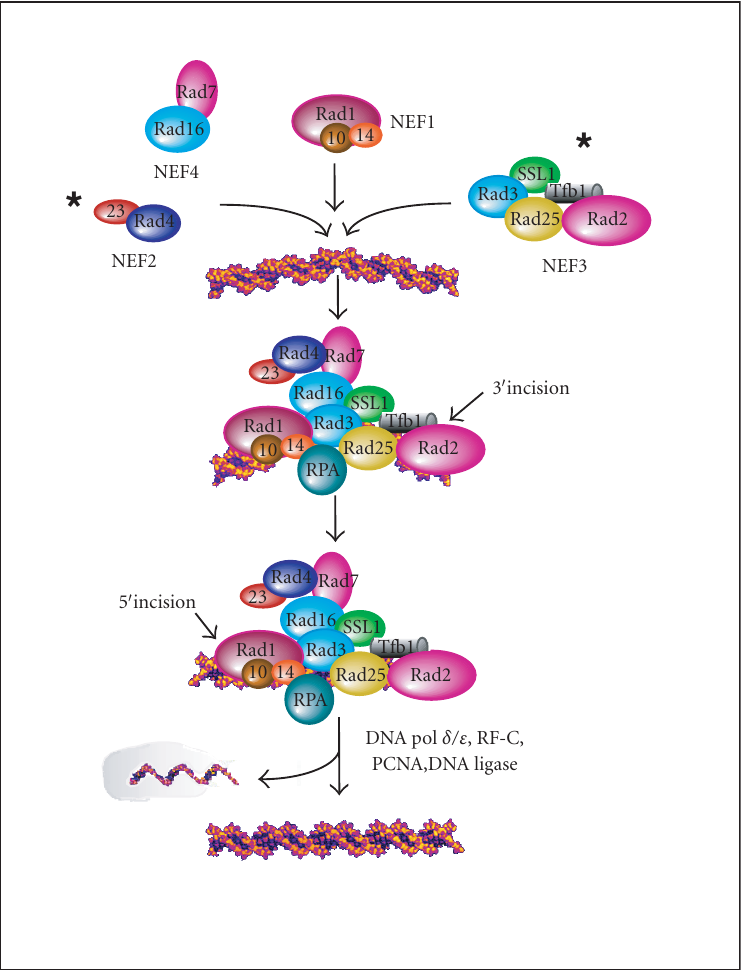
Figure 1. A model of yeast nucleotide excision repair. The biochemical details of the incision and size of the DNA oligonucleotide that is excised by yeast NER proteins has been determined, and is mechanistically similar to the human system [2, 5]. An asterisk indicates the presence of repair proteins that interact with the proteasome. Mutations in most genes that encode nucleotide excision repair proteins result in severe UV sensitivity. The order of repair complex assembly has been extensively studied, though the biochemical steps that follow DNA excision and gap-filling are unknown. The recycling of RNA polymerase II following exposure to a DNA-damaging agent has been suggested [76]. However, the lack of an in vivo or in vitro assay to measure the recycling, dismantling, and degradation of the repair complex, reveals significant steps in the cellular response to DNA damage that remain to be